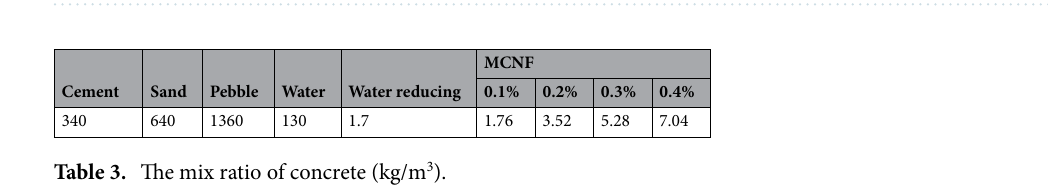
Figure 1. Monofilament droplet debonding test chart.